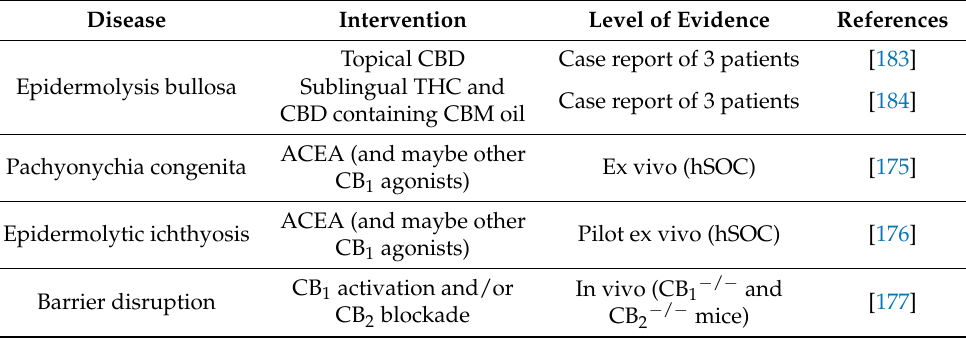
Overview of the putative keratinocyte-relevant therapeutic potential of cutaneous cannabinoid